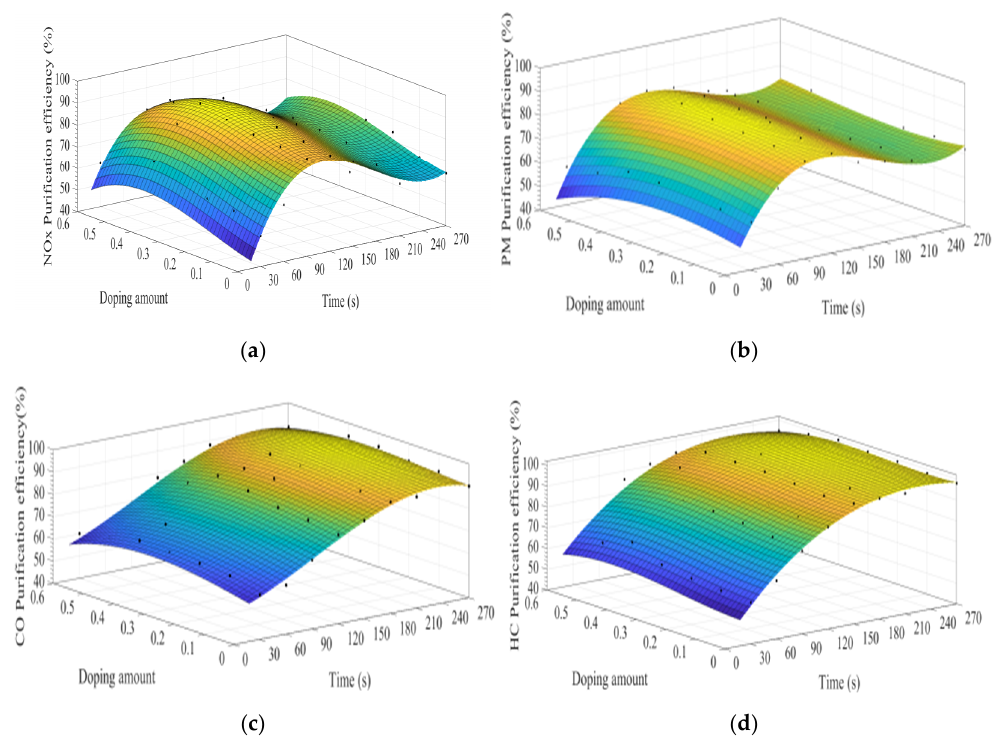
Figure 7. Purification efficiency curve of catalyst when A site was doped with ceriumions: ( a ) NO x ; ( b ) PM; ( c ) CO; and ( d ) HC.